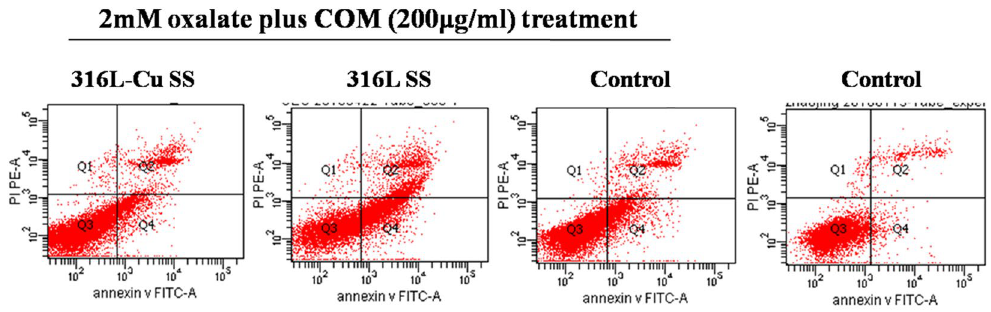
Figure 2. Flow cytometric analyses of the apoptosis of UECs. Cells were seeded on the samples and exposed to oxalate (2 mM) plus COM (200 μ g/ml).